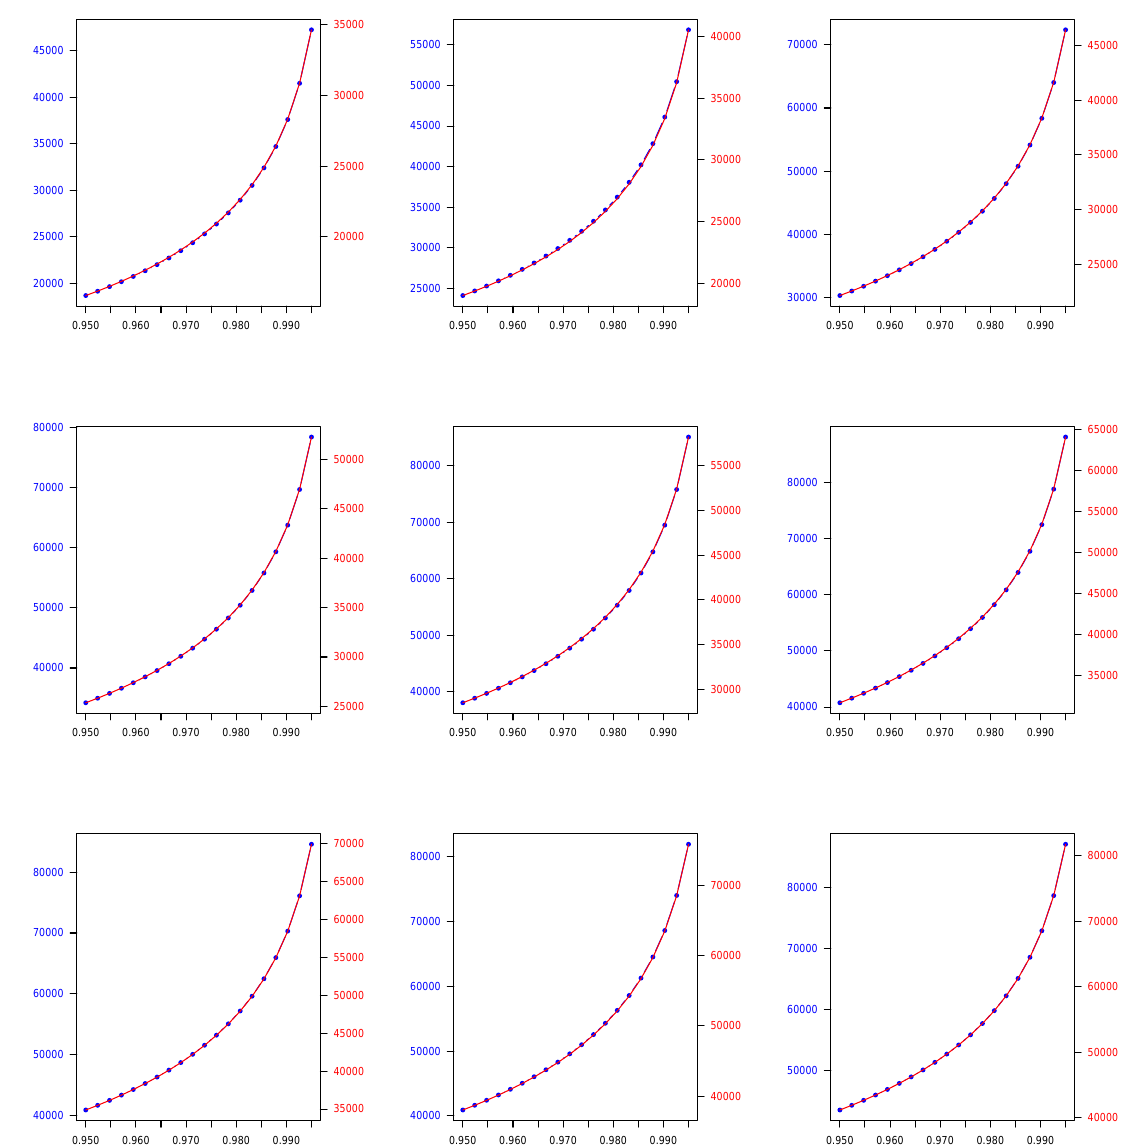
Figure 2. Two-Component (2C) Lognormal finite mixture model-based (1 − α ) quantile Q mix . (blue colour) across all ( ˆ π 1 , ˆ π 2 ) combinations versus two-component (2C) Lognormal weighted average-based (1 − α ) quantile Q w . a . (red colour) across all ( π 1 , π 2 ) combinations, where (1 − α ) takes values in the range of 0.950-0.995. Note that, due to a considerable discrepancy between Q mix . and Q w . a . values, each given plot has two different y axes—one for each quantile